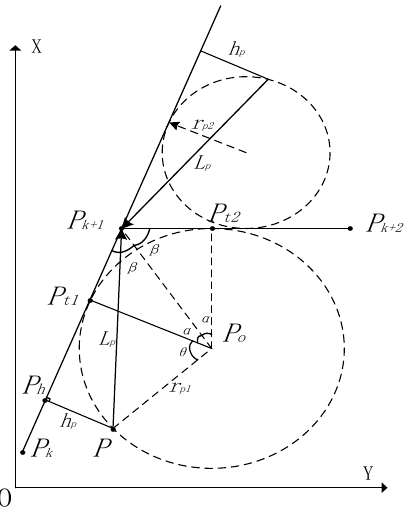
Figure 13. Multi solution problem of turning point control.